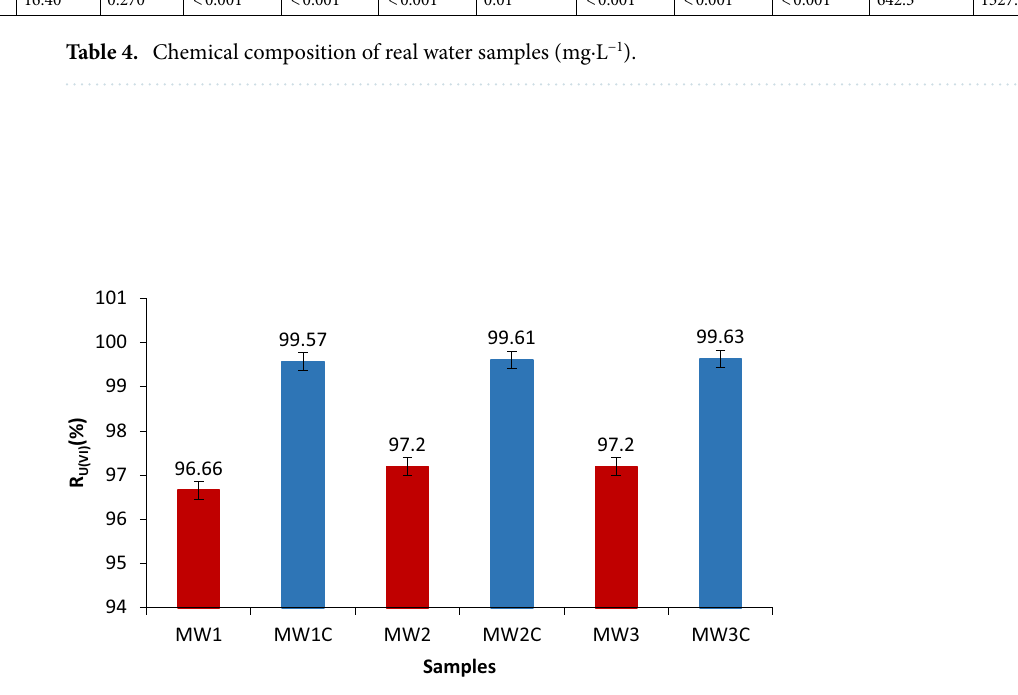
Figure 11. %R U(VI) = f (pH adjustment), V sample = 200 mL, stirring rate 250 RPM, contact time 30 min, molar ratio [U(VI)] : [Fe (III)] : [NaOL] = 1 : 75 : 1 × 10 –2 , p = 4 × 10 5 N·m −2 , dilution ratio V sample : V water = 3 : 1,